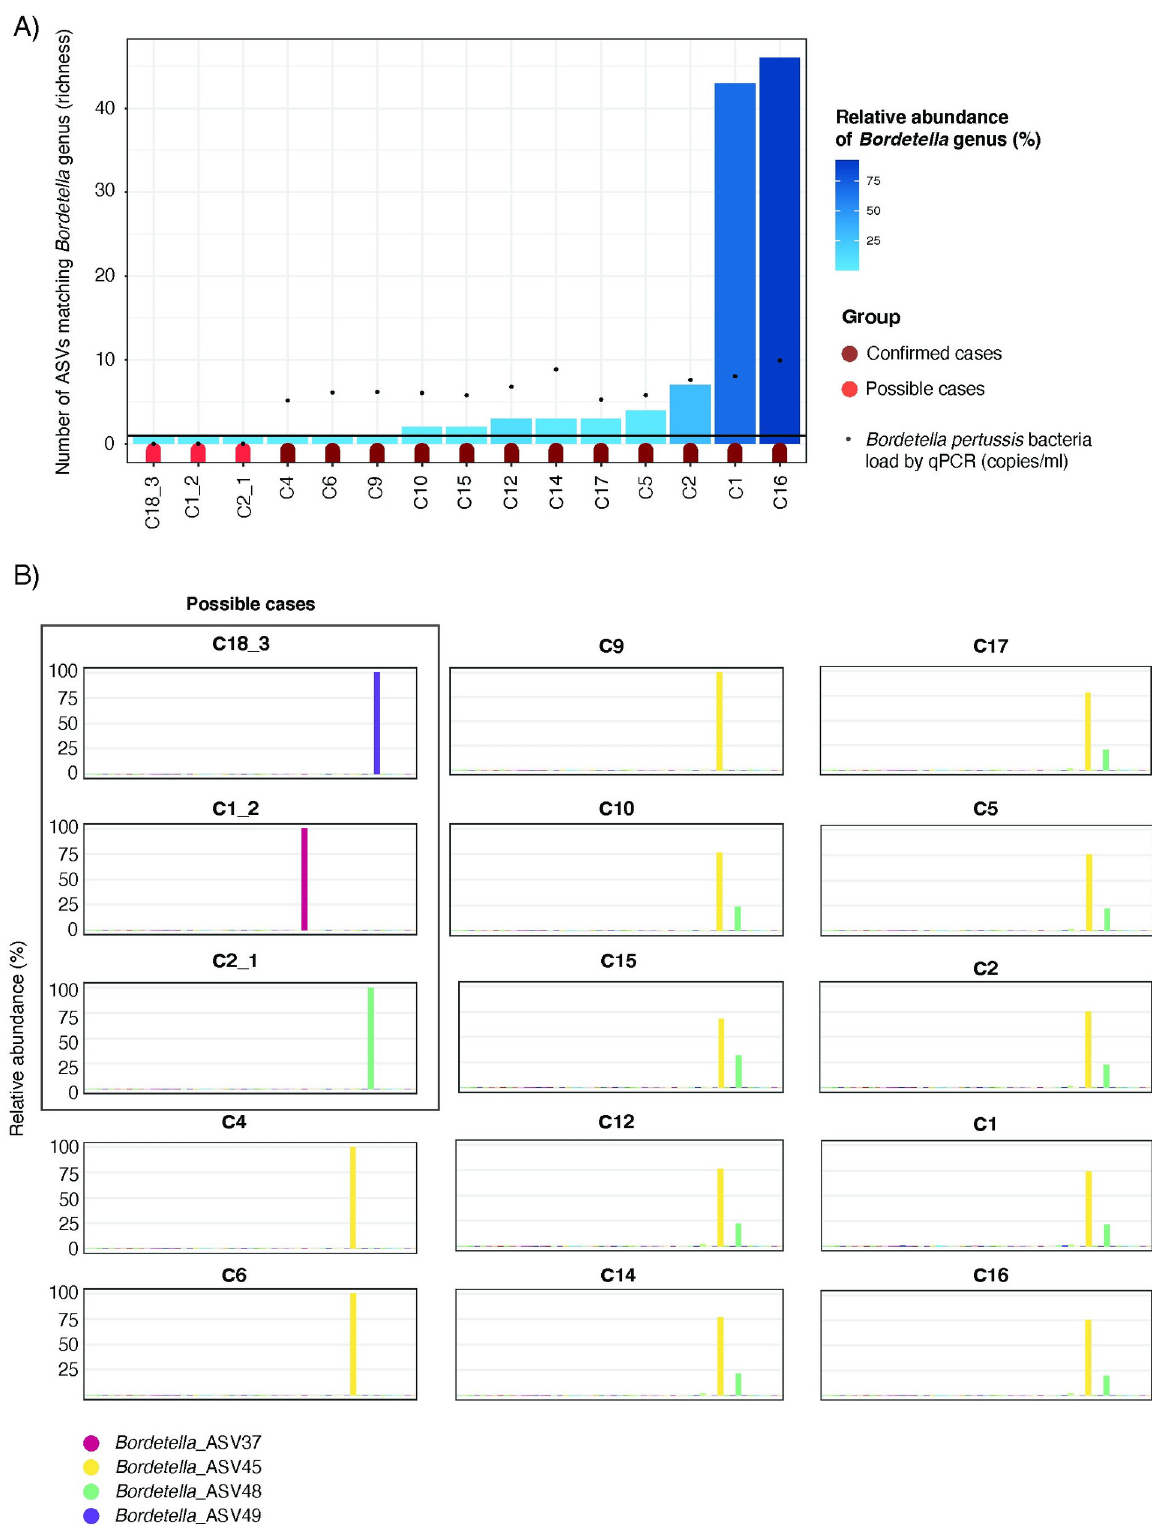
Fig 3. Increased Bordetella detection sensitivity by 16S rRNA gene sequencing. A) Barplot showing Bordetella detection by 16S rRNA gene sequencing. Height of bars represent the total number of unique 16S rRNA gene sequences (Amplicon Sequencing Variants, ASVs)